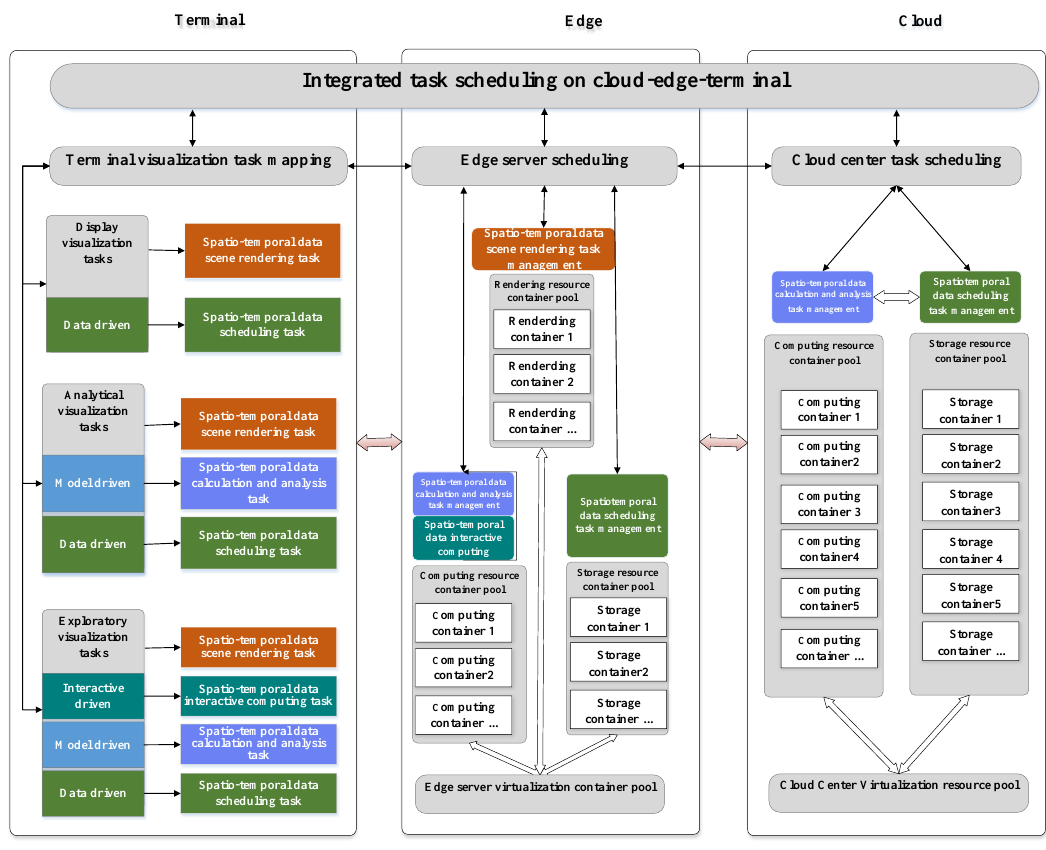
Figure. 1 Integrated scheduling model of cloud-edge- terminal for multi-level visualization tasks = analytical visualization task = exploratory visualization